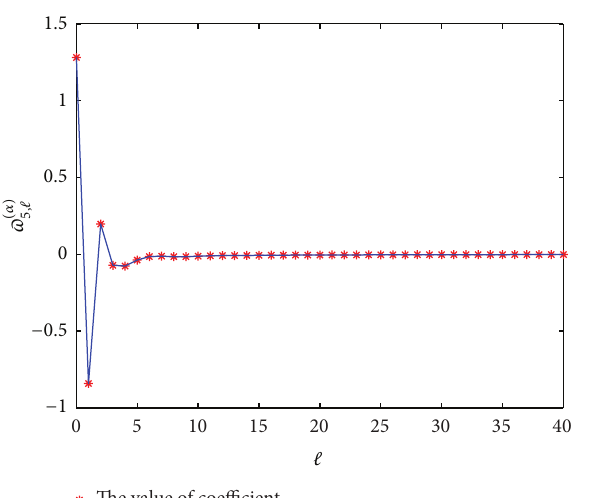
Figure 5: The values of the coefficients 𝜛 (𝛼) 7,ℓ (ℓ = 0, 1, . . .) for 𝛼 = 0.3